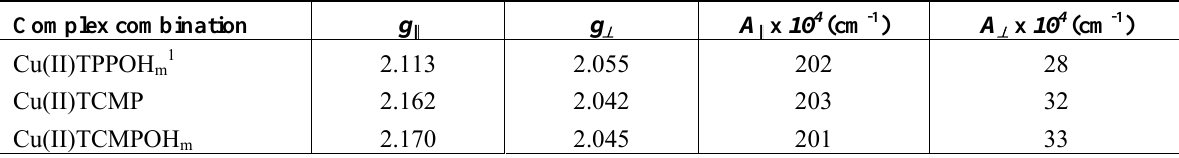
Table 3. Magnetic parameter values corresponding to Cu(II) complex combinations with porphyrinic